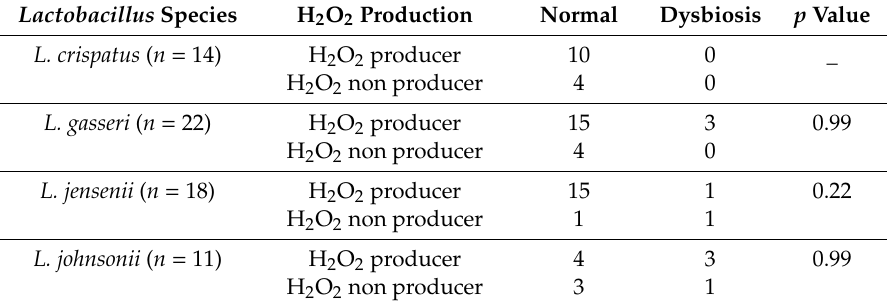
Table 1. Diversity of H 2 O 2 production by Lactobacillus species from normal and dysbiotic (intermediate and BV) microbiota. Semi-quantitative measurement of H 2 O 2 production on MRS-TMB-HRP agar by lactobacilli isolates was evaluated based on the intensity of blue color obtained on colonies. n = number of isolates of Lactobacillus species. Fisher’s exact test was carried out to determine the statistical